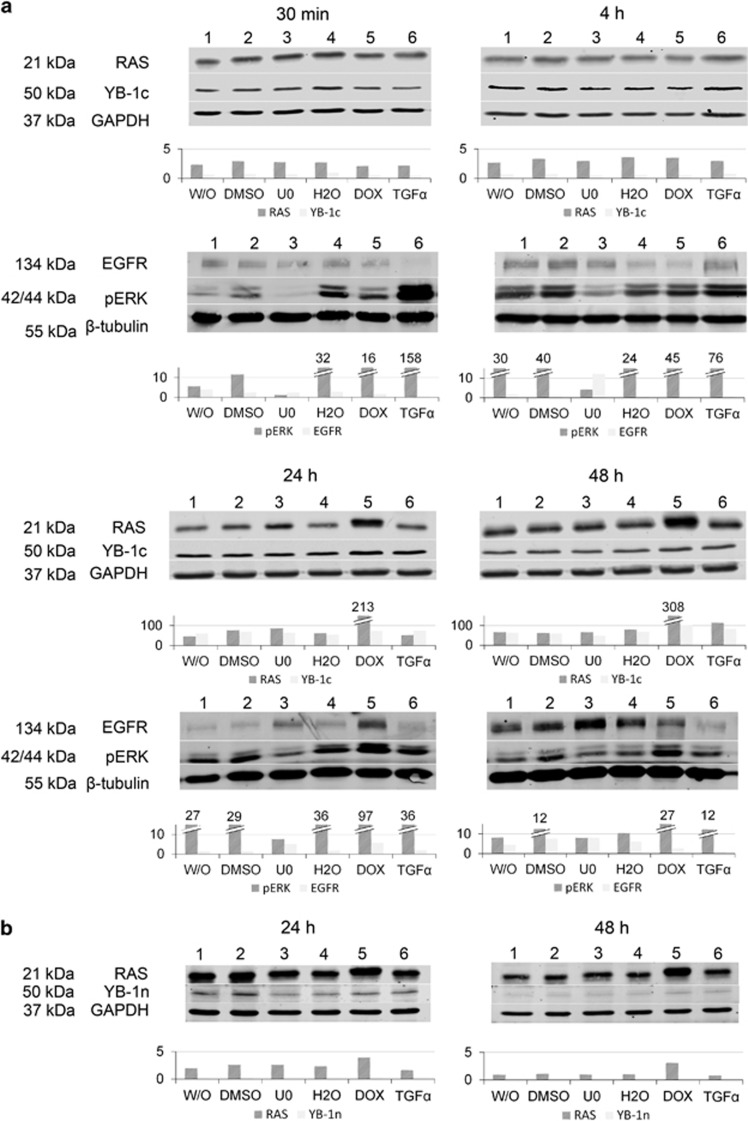
(a) Expression of RAS, pERK and YBX1c in Caco2 cells following KRAS induction for 30 min, 4 , 24  and 48 h. RAS and phospho-ERK1/2 are induced after 24 and 48 h following doxycycline treatment. Phospho-ERK increases strongly after 30 min and 4 h following TGFα application; EGFR is induced 48 h after U0126 treatment. W/O (1), DMSO (2), U0126 (3), aqua bidest (4), doxycycline (5), TGFα (6). (b) RAS is upregulated after 24 h and 48 h of doxycycline treatment; again no change of YBX1n. W/O (1), DMSO (2), U0126 (3), aqua bidest (4), doxycycline (5), TGFα (6).